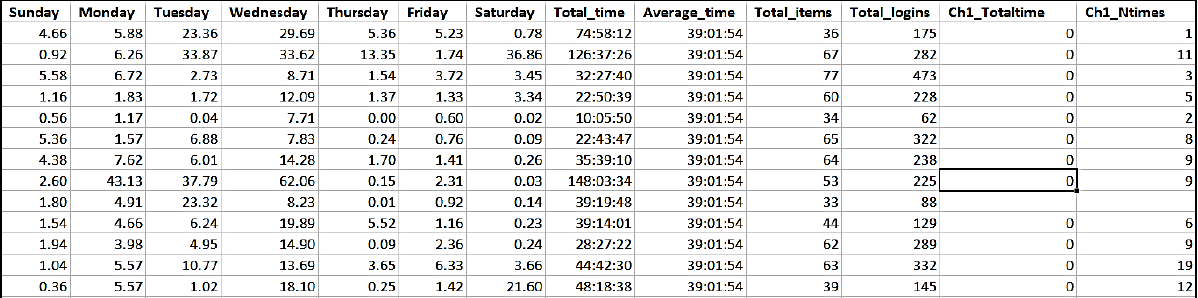
Figure 3. Aggregated students’ data to a single file.